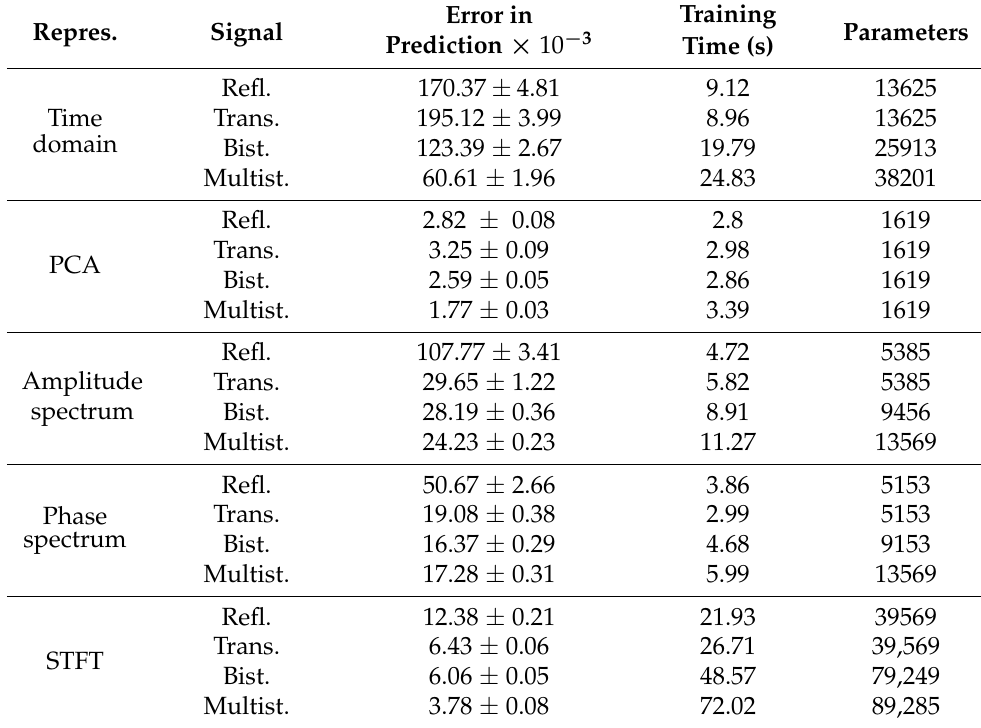
Table 2. Relative permittivity (cid:101) r parameter estimation with different representations.